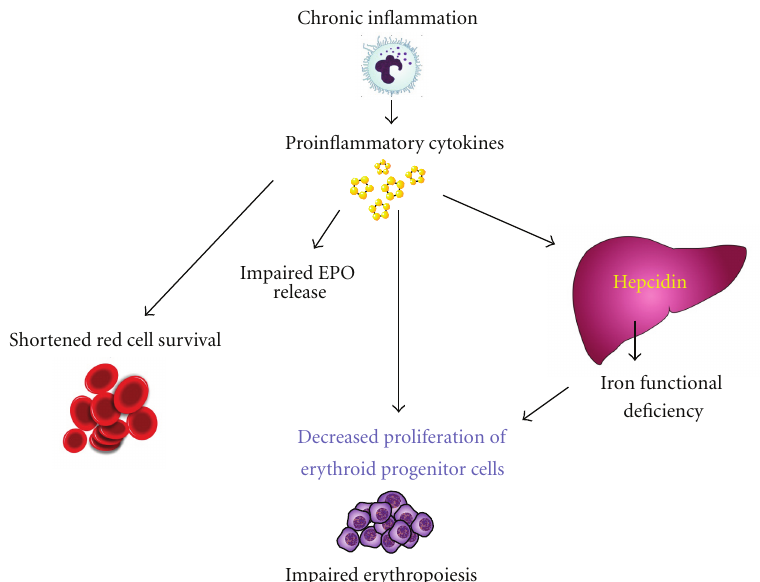
Figure 2: Pathogenesis of anemia of inflammation in the elderly. Abbreviations: EPO,